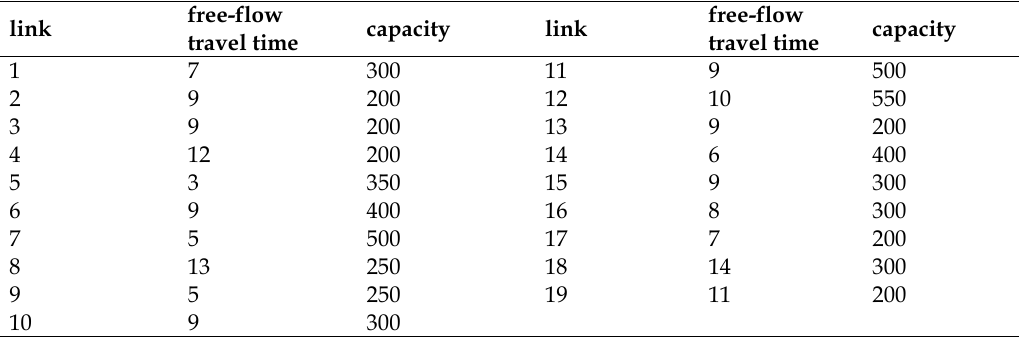
Table 7. Link characteristics of the example network